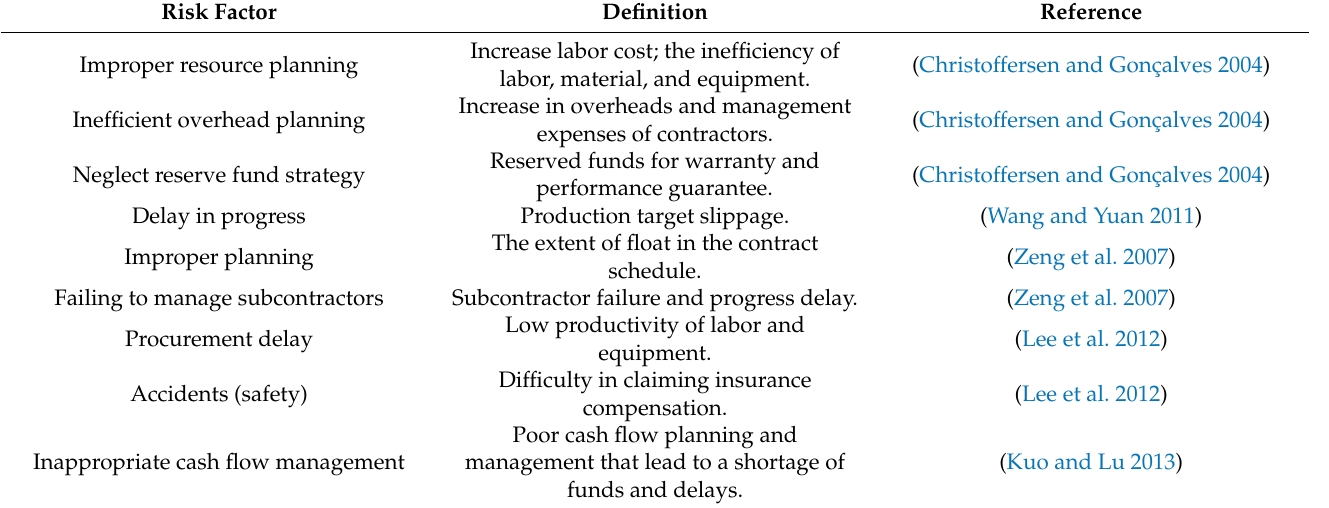
Table 3. Risk factors related to cash flow forecasting attributed to